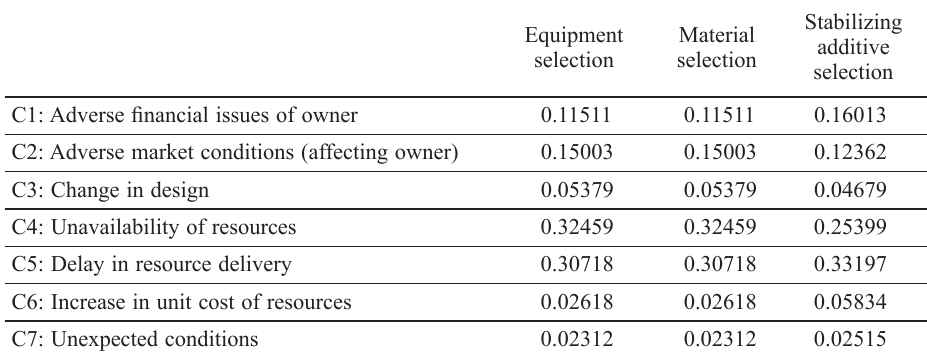
Table 8. Relative importance weights of project conditions